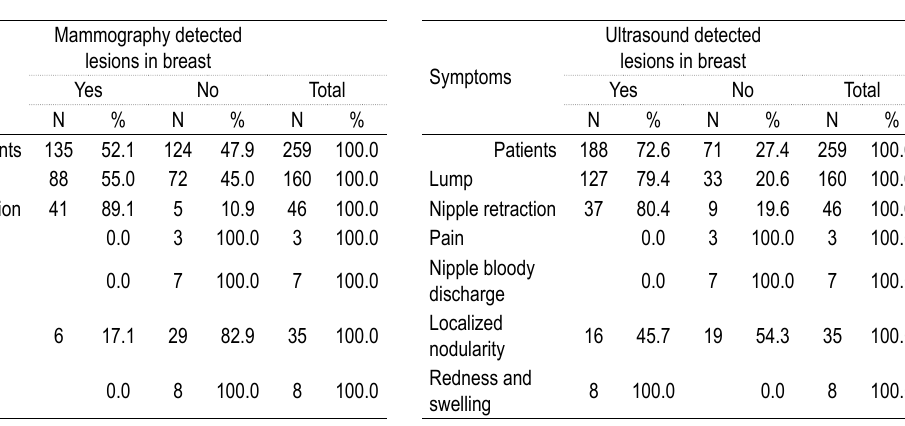
Table 5. Sensitivity of mammography in breast cancer diag- nosis according to symptoms